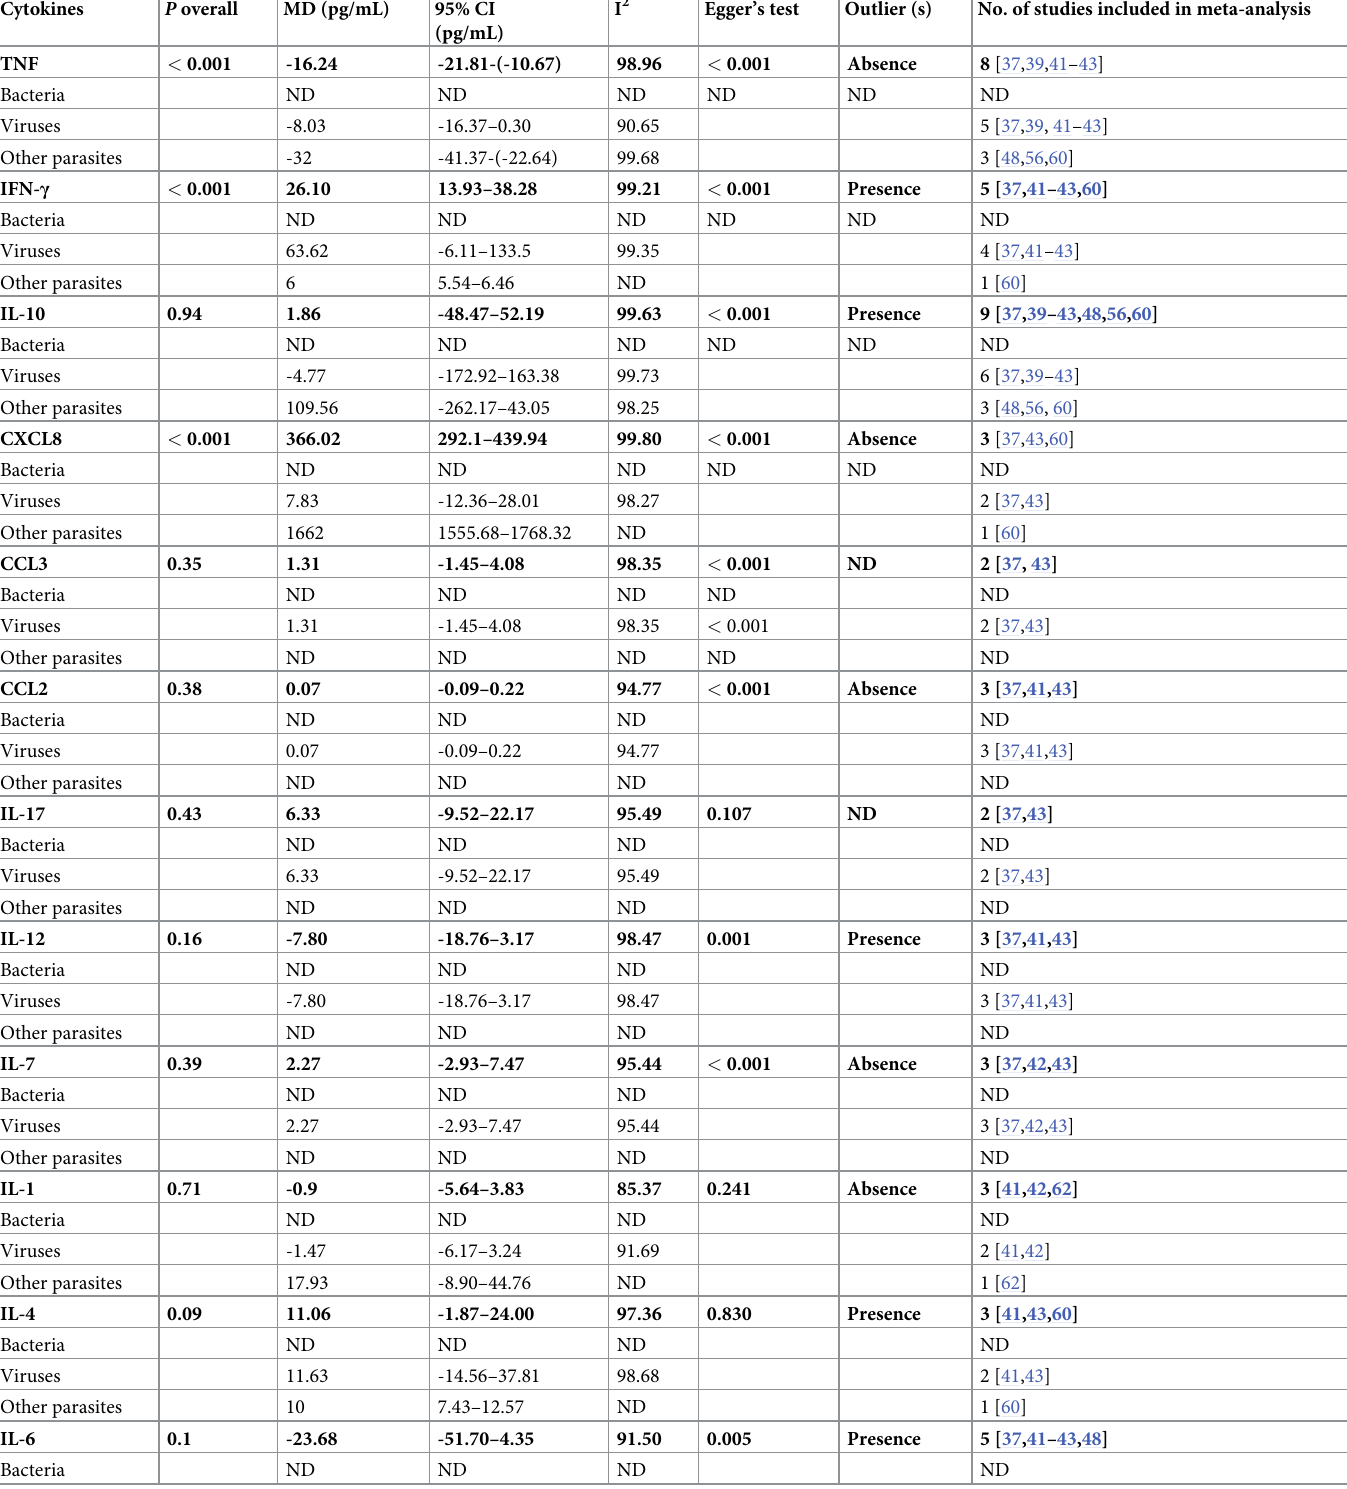
Table 2. Meta-analysis results of cytokines between coinfections and malaria